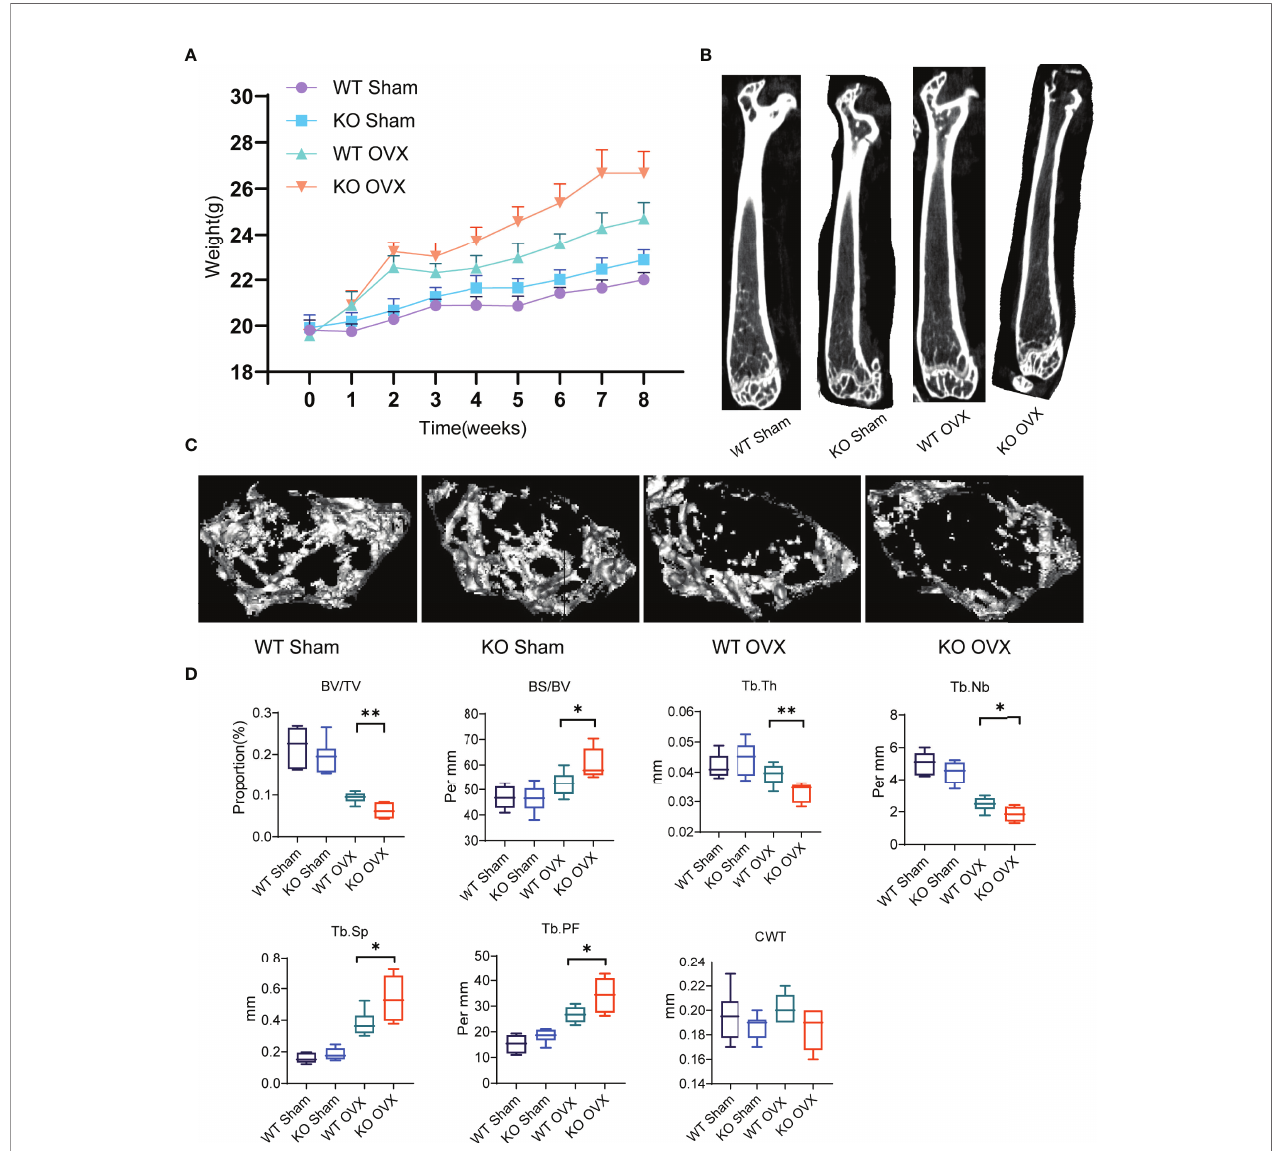
FIGURE 3 | NTCP de fi ciency aggravated osteoporosis in OVX mice. (A) Bodyweight of WT SHAM, KO SHAM, WT OVX, and KO OVX mice over 8 weeks after the establishment of OVX or SHAM models. (B, C) Representative micro-CT images showing vertical (B) and cross (C) sections of the femur of WT SHAM, KO SHAM, WT OVX, and KO OVX mice. (D) NTCP de fi ciency aggravated osteoporosis in OVX mice. BV/TV, bone volume/tissue volume; BS/BV, bone surface area/bone volume; Tb.Th, trabecular thickness; Tb.Nb, trabecular number; Tb.Sp, trabecular spacing; Tb.PF, trabecular pattern factor; CWT, cortical wall thickness. n = 6 mice per group. *, p < 0.05 and **, p <